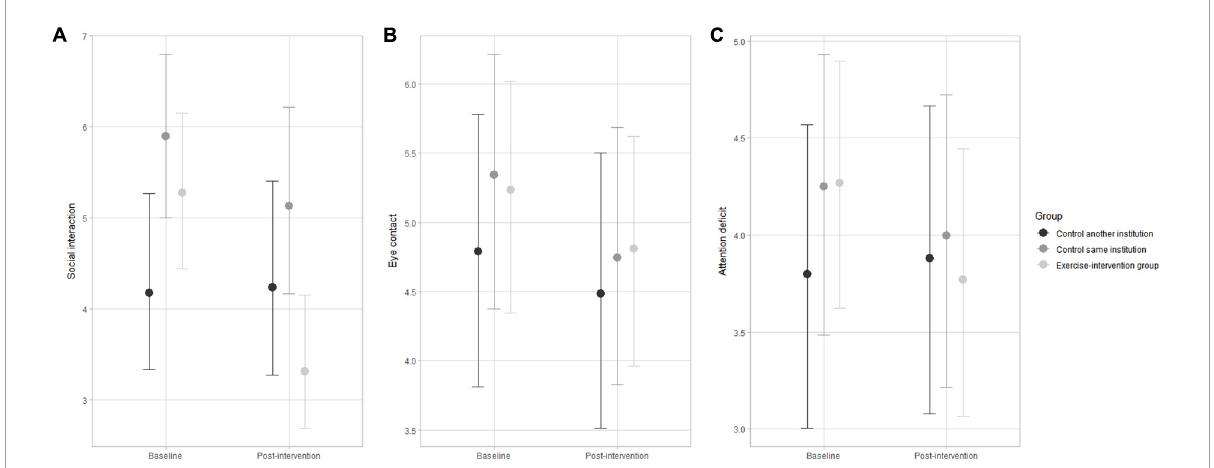
Exercise- Control Control intervention group group group same another ( n = 127) institution ( n = 62)